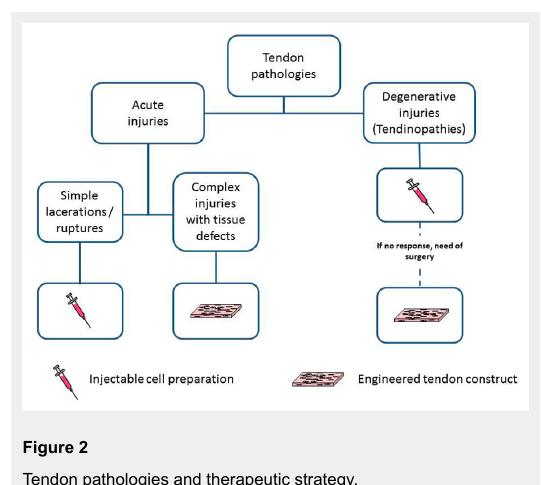
Figure 2 Tendon pathologies and therapeutic strategy. Tendon pathologies can be either acute or degenerative. Degenerative therapies could be treated with biological cellular therapies with injectable forms to delay degenerative responses and more invasive surgery. Acute injuries, depending on their severity, could be treated with either non-invasive to invasive technique with cells in viscous biogels to complex neo-tissue